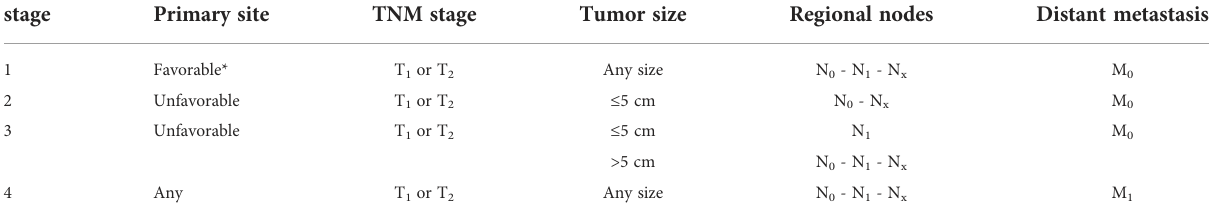
TABLE 2 TNM stage for rhabdomyosarcoma.